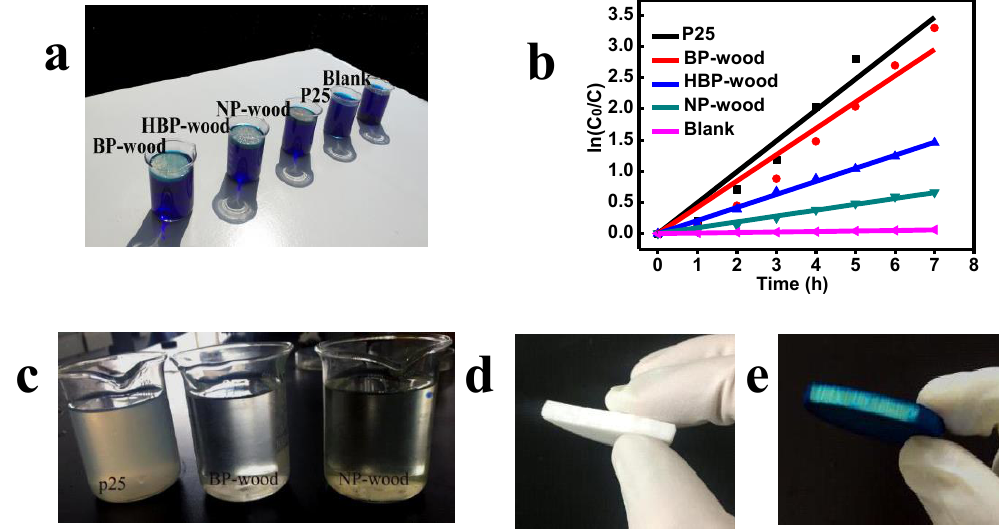
Figure 4. ( a ) Photo of photocatalytic degradation devices under sunlight. ( b ) Photodegradation of MB monitored as the normalized concentration change versus irradiation time under sunlight. Photo of ( c ) MB solutions, ( d ) BP-wood, and ( e ) NP-wood after photodegradation of MB solution under sunlight.